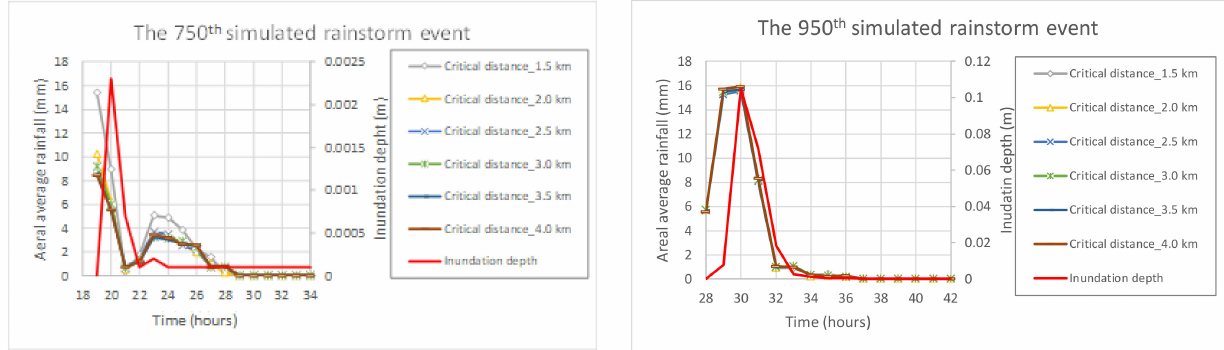
Figure 8. Relationship between the inundation depth and associated areal average of rainfall calculated using the simulated gridded rainfall with the specific distances from the IoT sensor of